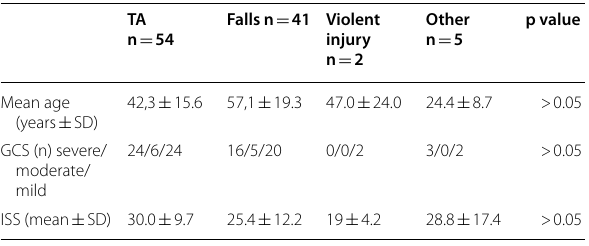
Table 2 Comparison of patients’ age, GCS, ISS and mortality according to TBI formation mechanism